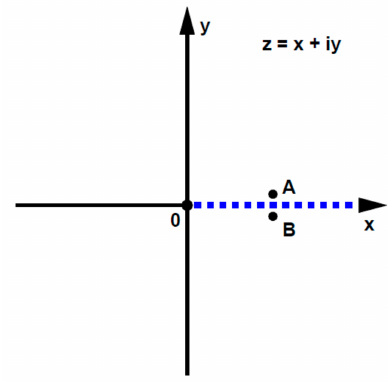
Figure A2. Representation of branch cut at positive x-axis showing discontinuity across two points A and B